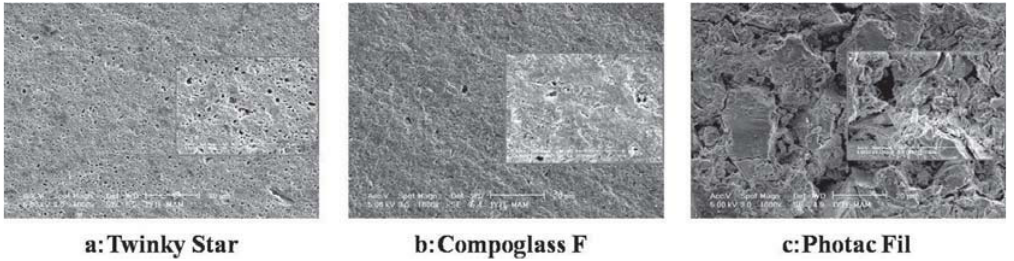
Figure 5- SEM micrographs of the specimens after APF gel